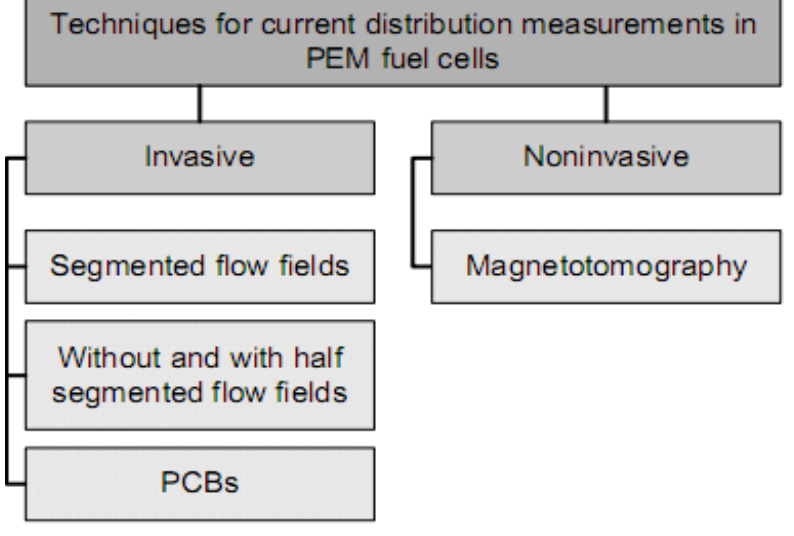
Figure 1. Overview of already realized CDD measurement techniques, cp.